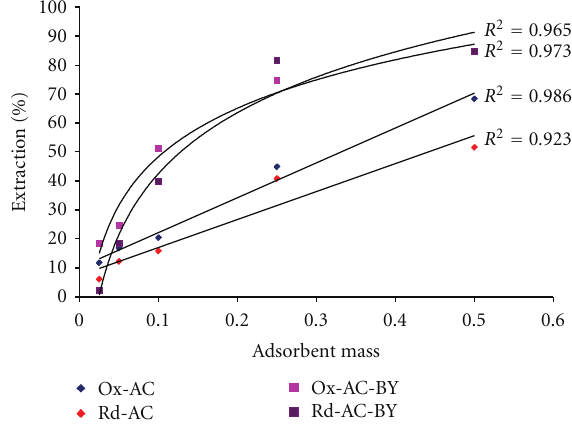
Figure 5: E ff ect of sorbent dose on Pb(II)